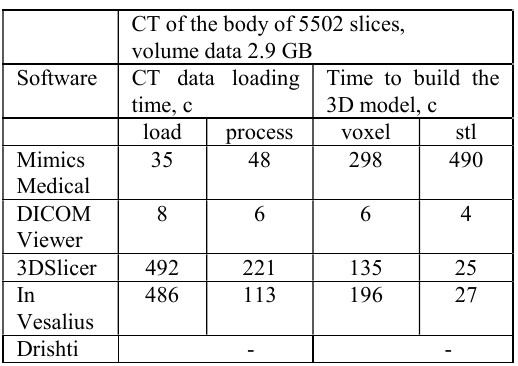
Table 2 . Comparison of the time of processing and conversion of tomographic data. an easy task.